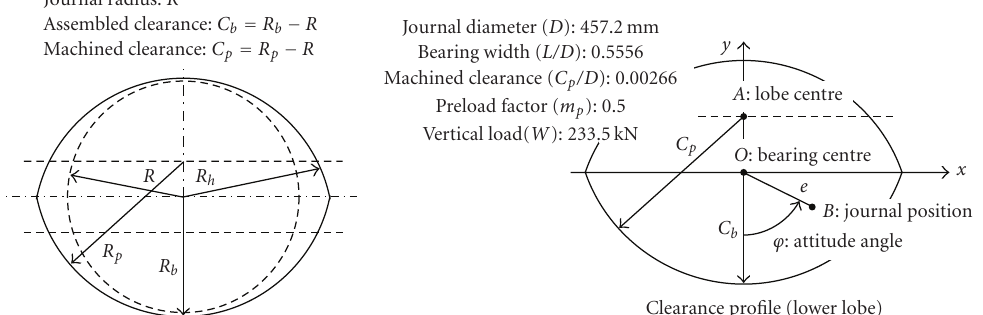
Journal radius: R Assembled clearance: C b = R b − R